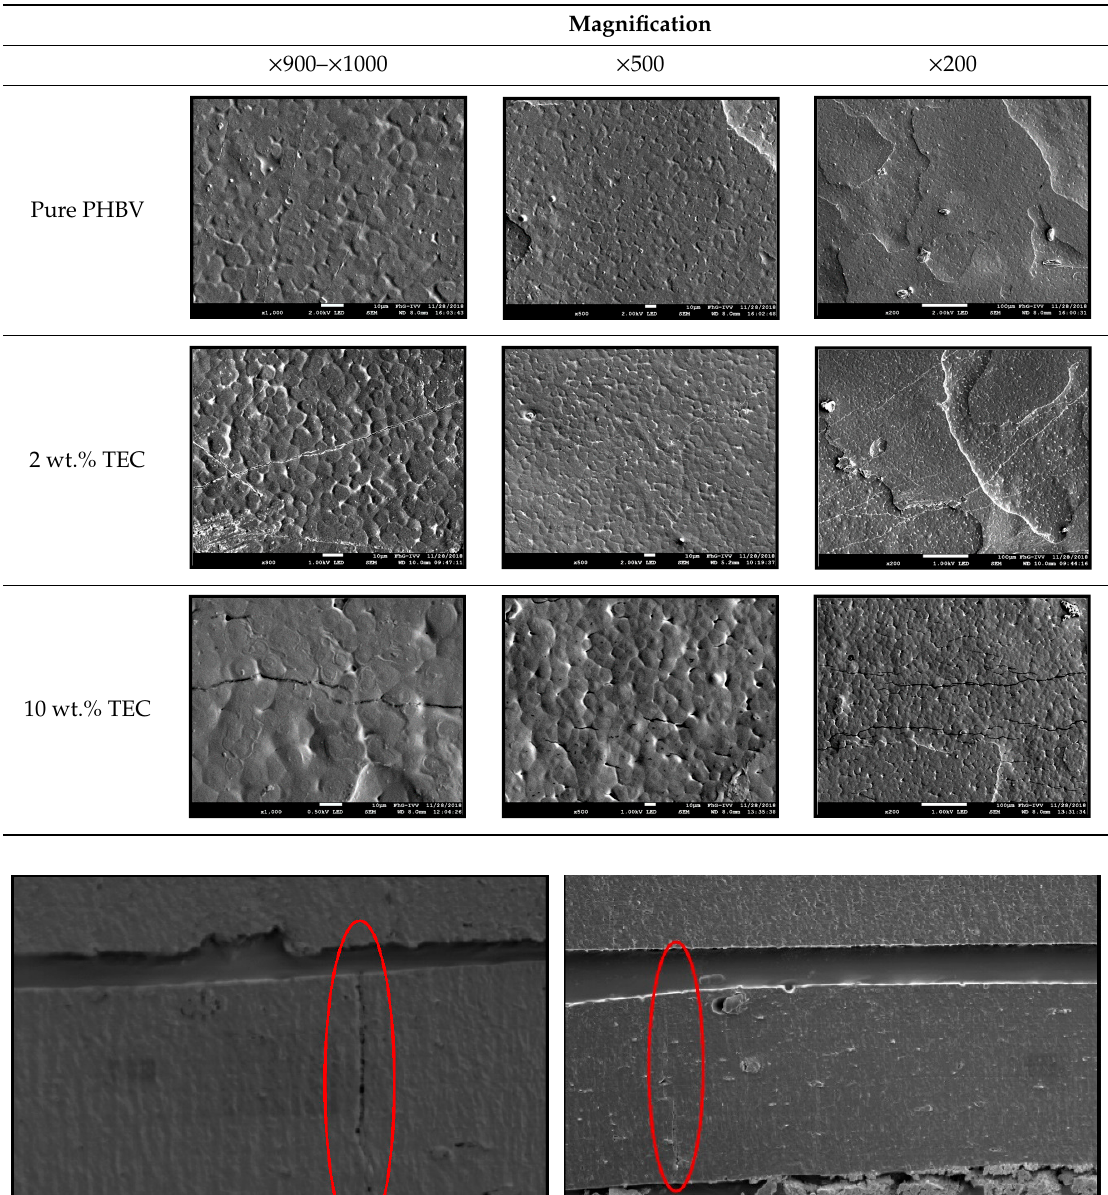
Table 6. Scanning electron microscopy (SEM) pictures of PHBV films blended with triethyl citrate (TEC).